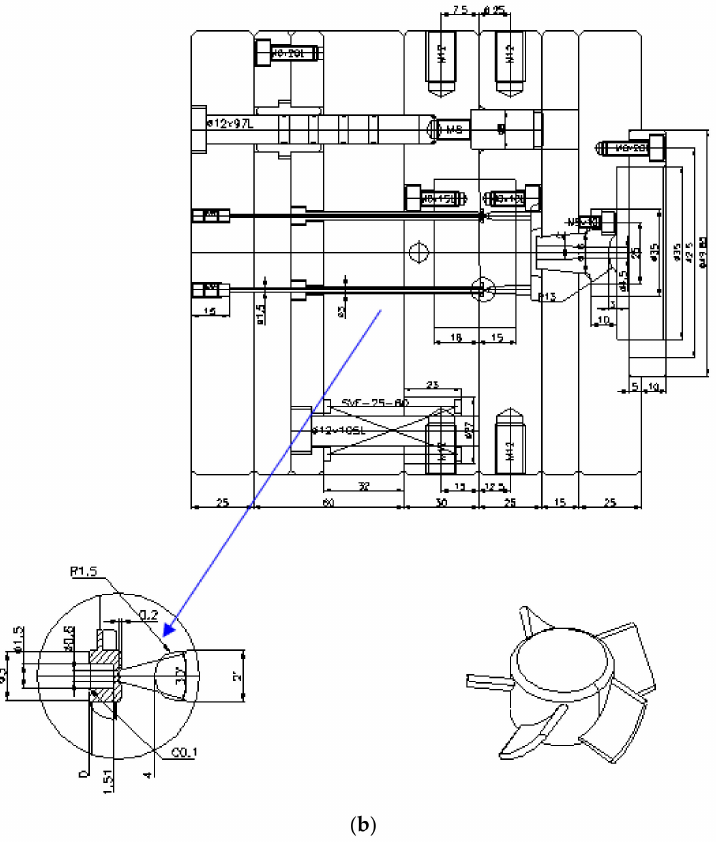
Figure 1. The dimensions of the micro-sized part and mold for PIM (unit: mm). ( a ) Micro-sized part (micro-electric fan) and ( b ) mold (side